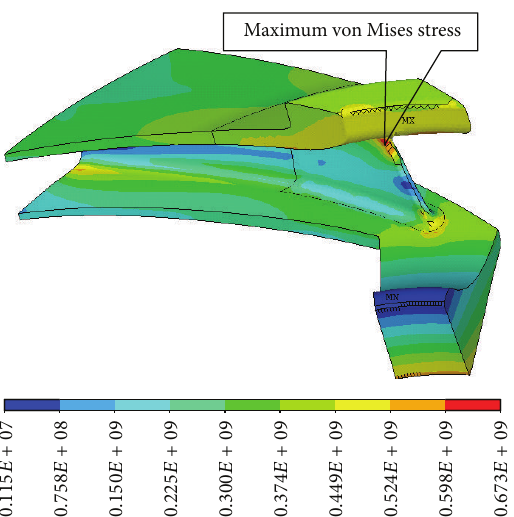
Figure 9: von Mises stress distribution of the impeller.